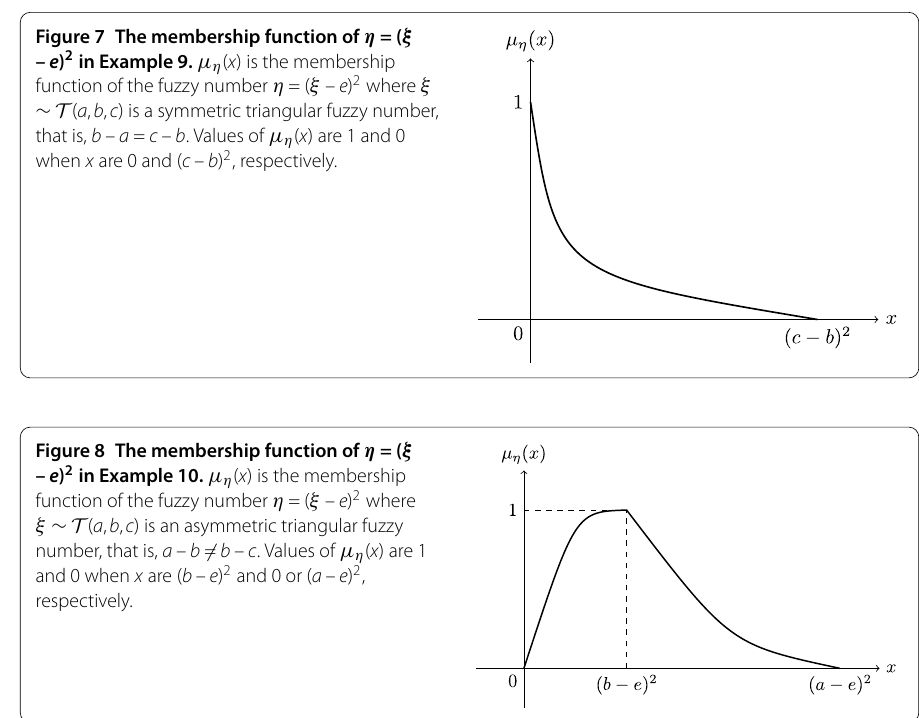
Figure 8 The membership function of η = ( ξ – e ) 2 in Example 10. μ η ( x ) is the membership function of the fuzzy number η = ( ξ – e ) 2 where ξ ∼ T ( a , b , c ) is an asymmetric triangular fuzzy number, that is, a – b (cid:11) = b – c . Values of μ η ( x ) are 1 and 0 when x are ( b – e ) 2 and 0 or ( a – e ) 2 ,